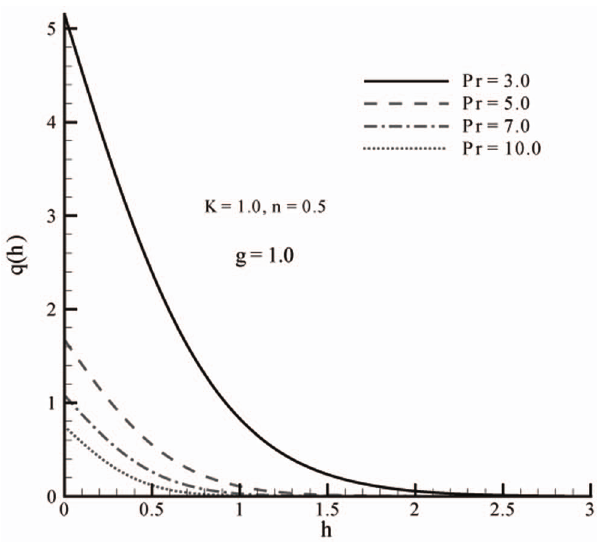
Figure 6. Influence of Pr on temperature profile h ( g ) when n ~ 0 : 5 :